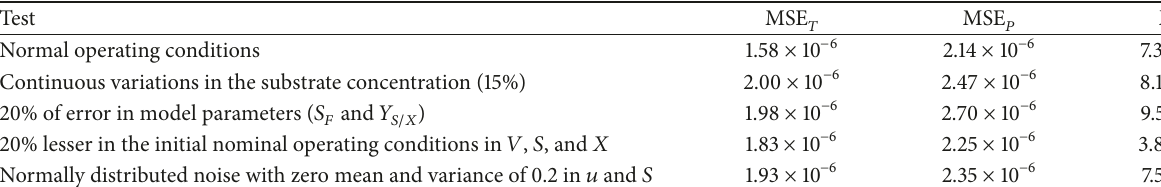
Table 1: Performance evaluation of the RBF neural network.